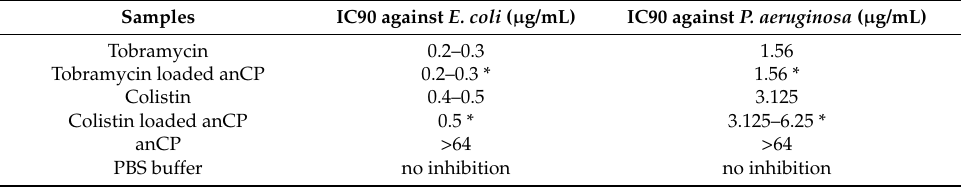
Table 3. MIC assay results against E. coli and P. aeruginosa.